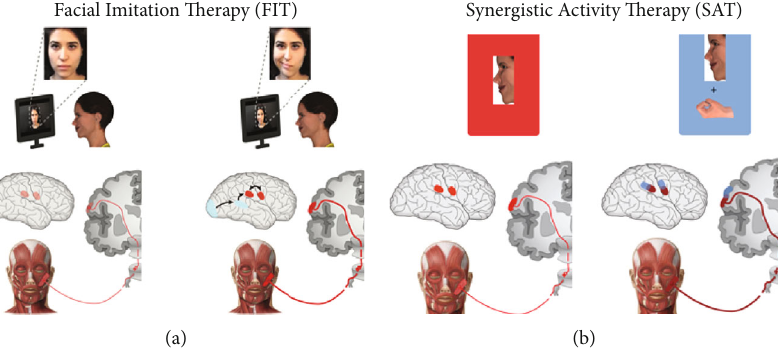
Figure 1: Modi fi ed from Ferrari et al. [21]: FIT-SAT theoretical assumptions. (a) FIT combined action observation with the direct e ff ects of action execution suggesting that activation of motor areas by action observation becomes reinforced by the concomitant active execution of the observed actions 19 ; (b) the synergistic activity of hand closing while smiling should facilitate the activation of the cortical areas connected to the mouth. We hypothesized that hand contraction would facilitate the recruitment of the gracilis muscle as a consequence of the activity of mouth motor neurons in motor cortical